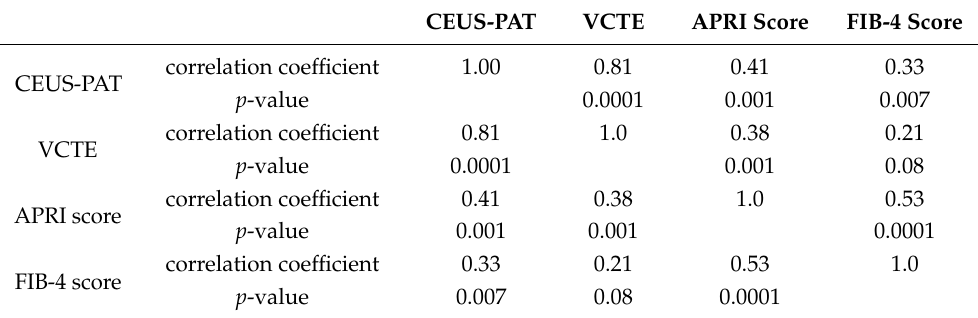
Table 3. Spearman correlation coefficients between the four methods.